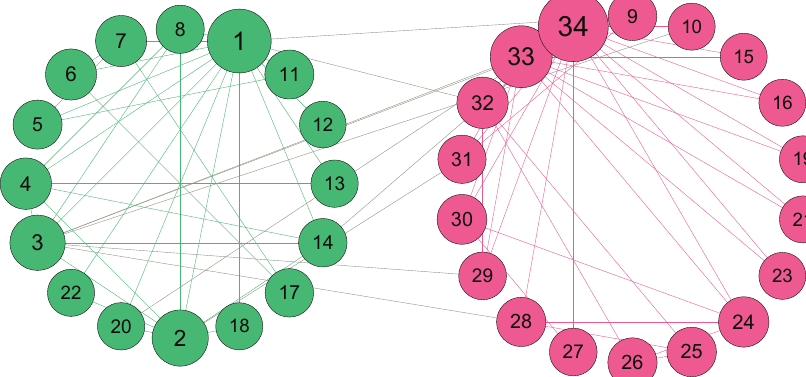
Figure 2. The final community structure of Karate according to the NINS